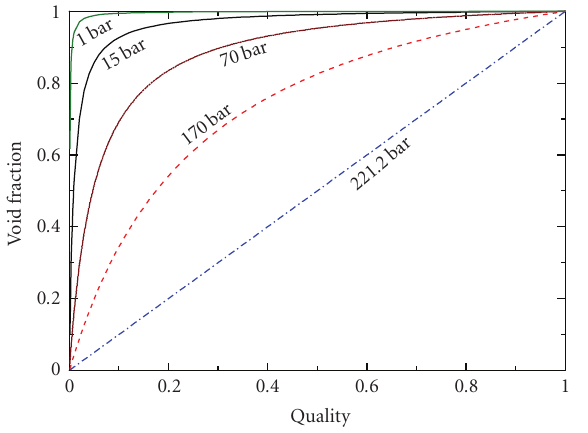
Figure 12: E ff ect of quality on void fraction.